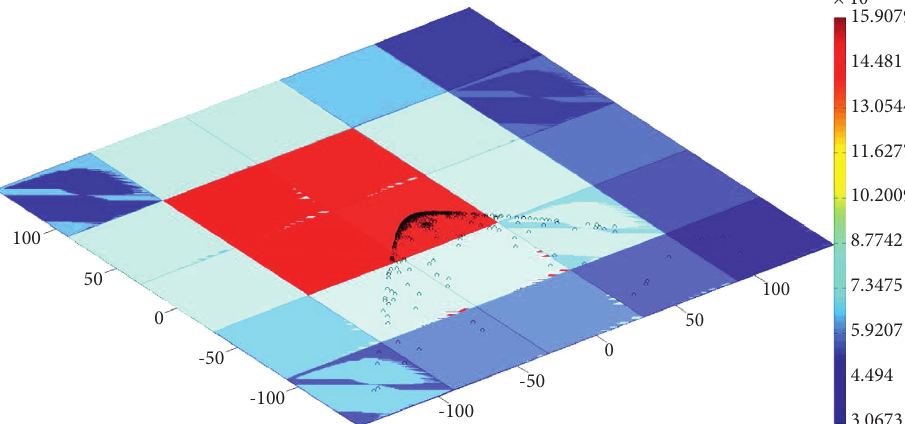
Figure 10: Ground damage distribution of multiple projectiles under continuous attacks.